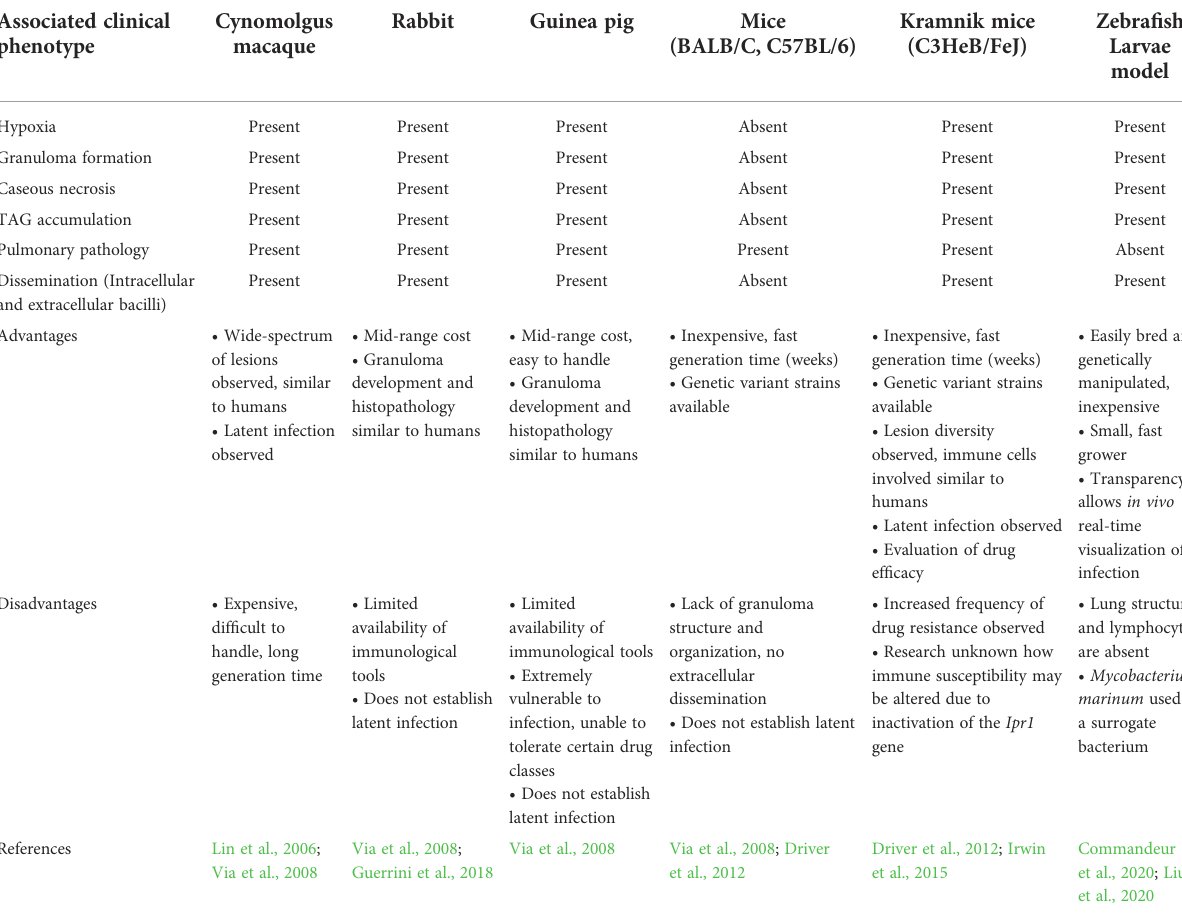
TABLE 1 M. tuberculosis progression of infection in animal